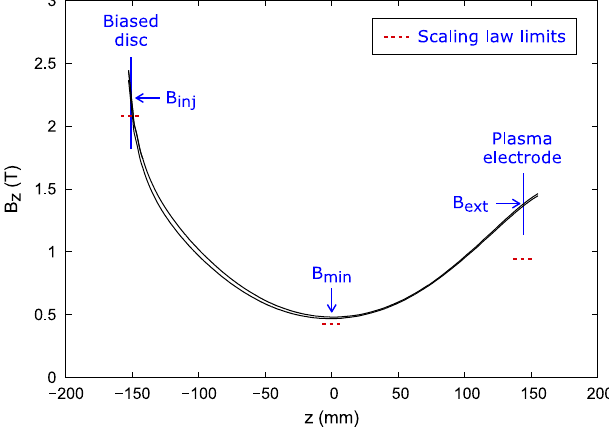
FIG. 2. The GTS-LHC ECR ion source injection plug, viewed 1. The on-axis magnetic field of the GTS-LHC and the fromtheplasmachamber.Atthecenteristhebiaseddisc(A),which conventional scaling law limits for 14.5 GHz ECRIS (dashed wrapsaroundthetwoWR62typerectangularwaveguides(B),seen ¼ 0 . 52 T. The lines). The resonance field for 14.5 GHz is B ECR in the figure on top left and right. The gas inlet is at the bottom (C), axial field variation due to different solenoid settings used in this surroundedonbothsides bythetwo circular ovenports,oneshown work falls within the presented range of field strength. The biased empty (D) and the other with the oven in place disc and the plasma electrode locations represent the axial boundaries of the plasma